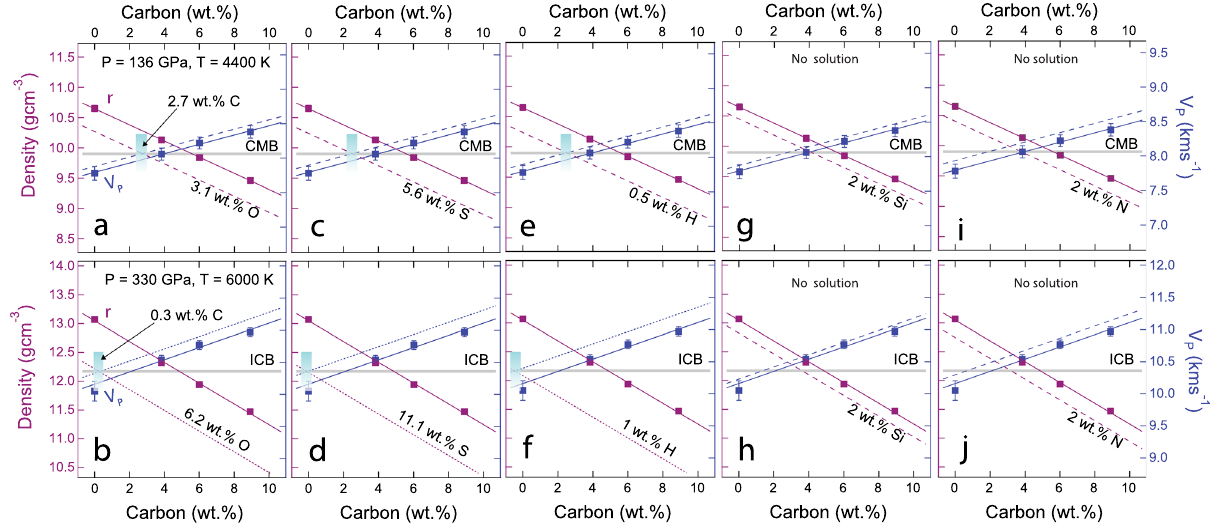
Fig. 4 Carbon content of the Earth ’ s outer core. The effects of other light elements ( a , b ) oxygen, ( c , d ) sulfur, ( e , f ) hydrogen, ( g , h ) silicon, and ( i , j ) nitrogen at CMB (upper panels) and ICB conditions (lower panels) on the ρ and V P of liquid iron as a function of carbon content. ρ is plotted on the left axes (purple) and V P on the right axes (blue) in all panels. Pressure is corrected using thermodynamic constraints, P th in each panel shows the density and compressional wave velocity at core conditions from preliminary reference earth model 71 . We note that the d ρ d V P for Si and N are very similar to that of carbon and hence it dif fi cult to obtain a unique solution with Fe – Si – C and Fe – N – C ternary systems. Green bar in d X LE panels ( a – f ) indicates the unique solution in Fe – C – LE ternary that simultaneously explain ρ and V P at ICB or CMB conditions. No unique solution is found for ( g , h ) Fe – C – Si and ( i , j ) Fe – C – N ternary systems. Error bars represent ±1 σ